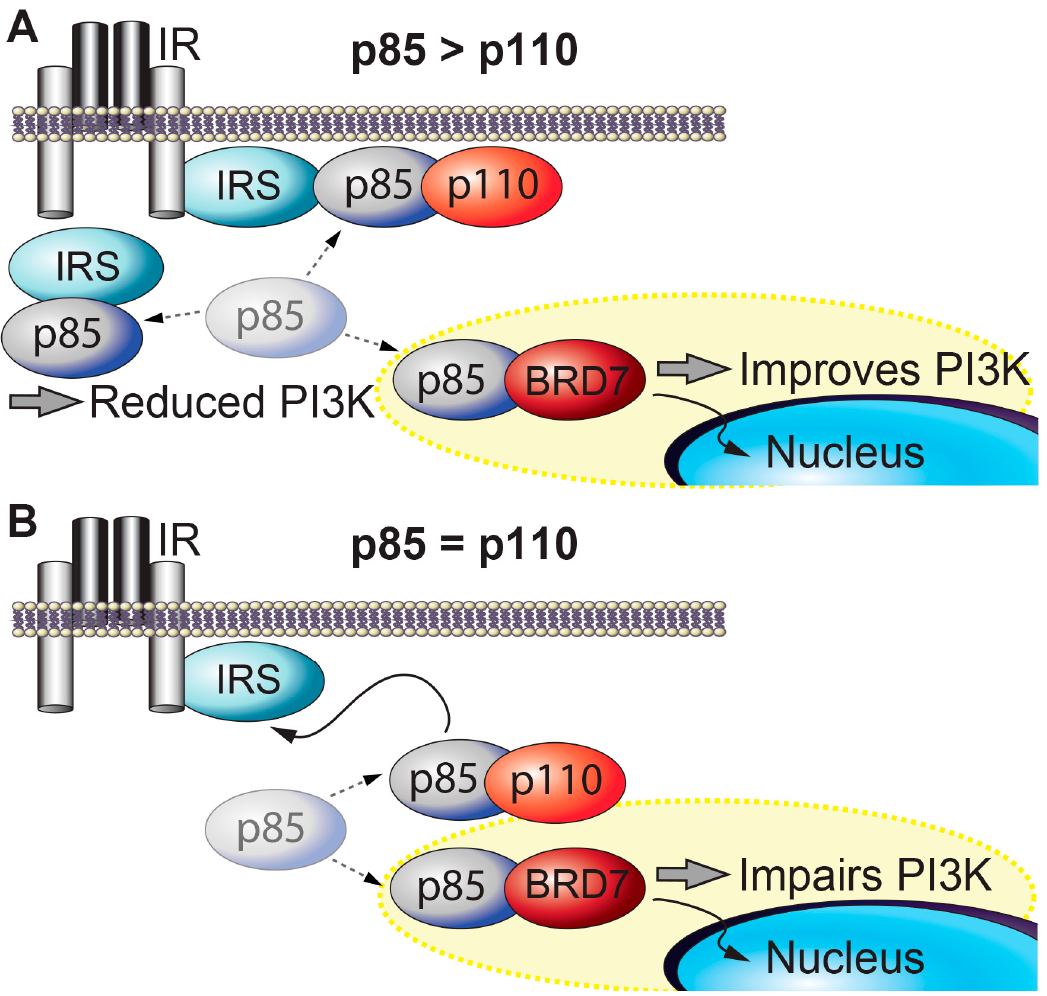
Figure 1. BRD7 and insulin signaling. ( A ) When p85 is present in excess of p110, free p85s inhibit PI3K (p85-p110) from binding to IRS. Overexpression of BRD7 removes free p85s from the cytoplasm to the nucleus and improves PI3K signaling. ( B ) When the amount of p85 and p110 is similar,